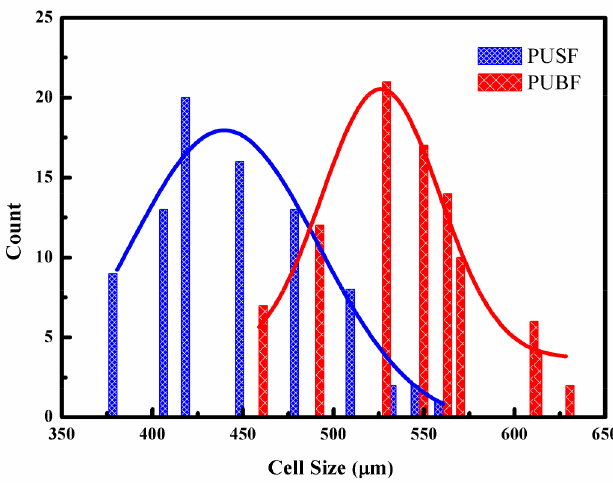
Figure 4. Cell distributions of PU foam